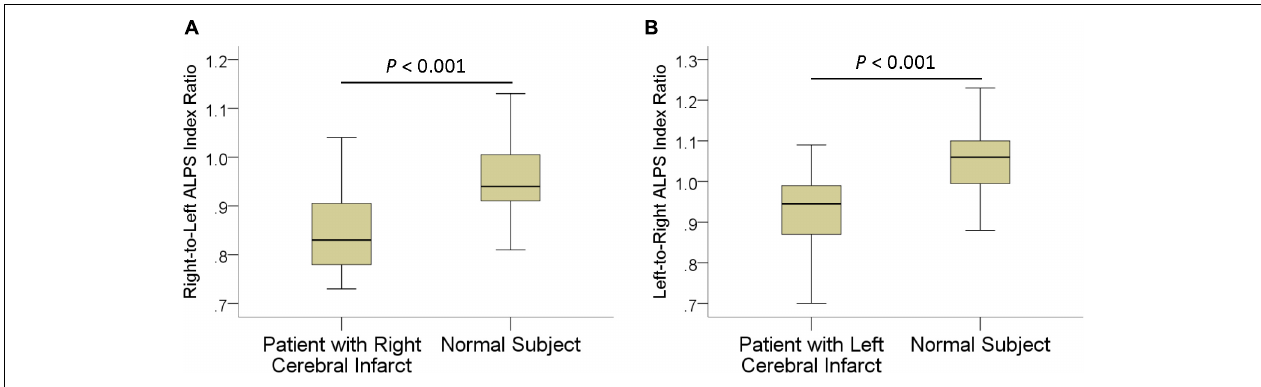
FIGURE 3 | Boxplots show differences in right-to-left (A) and left-to-right (B) ALPS index ratios between patients with ischemic stroke and normal subjects.